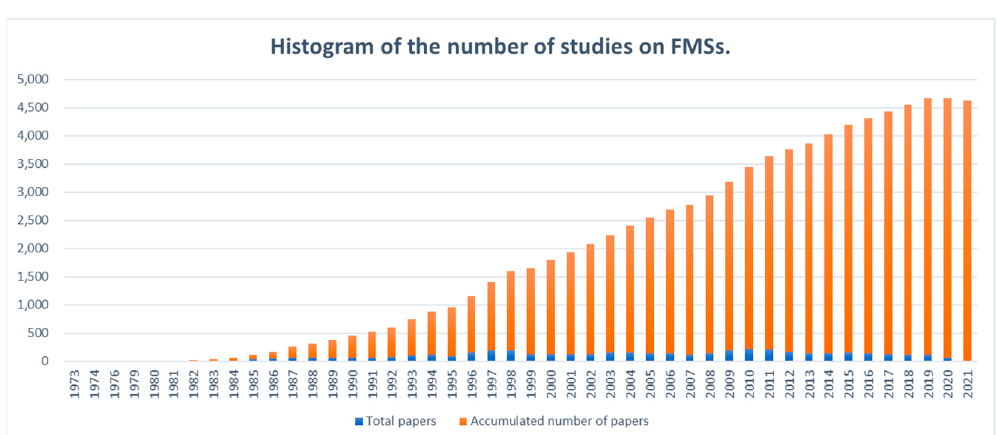
Figure 2. Histogram of the number of studies on FMSs.